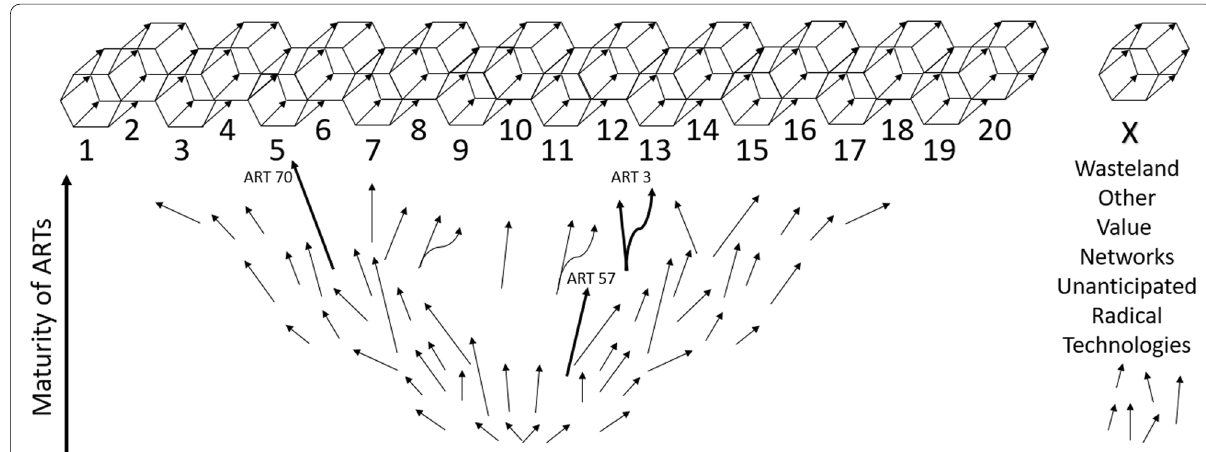
Fig. 3 Model of global socio-technical system as 20 global value-producing networks (prisms) and anticipated impacts of 100 anticipated radical technologies (arrows) on